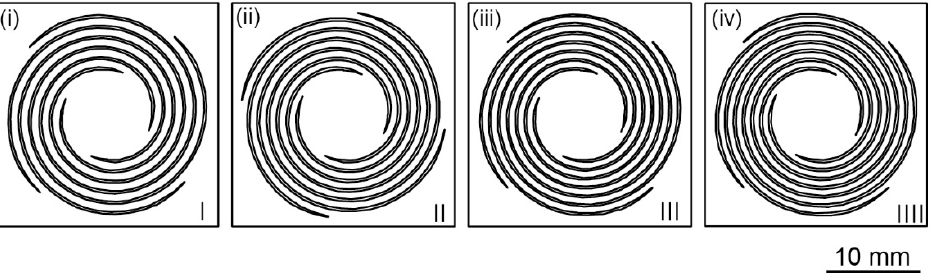
Figure 3. Design drawings of each force plate according to the parameters shown in Figure 2. The coil width w , pitch p , and turn n differ from each other. The order of (i), (ii), (iii), and (iv) are corresponding to those of Figure 2.